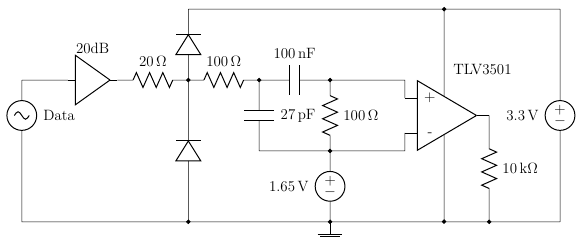
Figure 5: Receiver analogue front end spice model. The 20dB gain block and associated clamping diodes used to model an off the shelf low noise